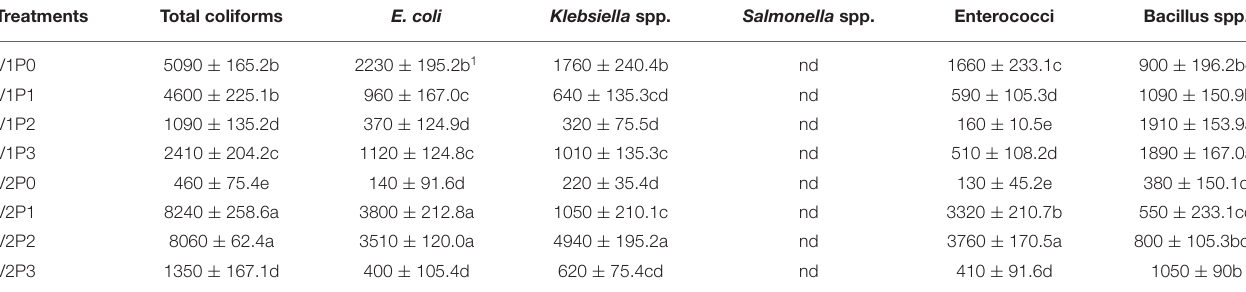
TABLE 4 | Viable counts of selected bacterial organisms detected on leaves from two lettuce cultivars ( Lactuca sativa cv. Green Wave, V1; Lactuca sativa cv. New Red Fire, V2) leaves grown in different organic growing media (P0: control, 100% soil; P1 : 40% soil + 40% vermicompost + 20% cocodust; P2: 50% soil + 50%